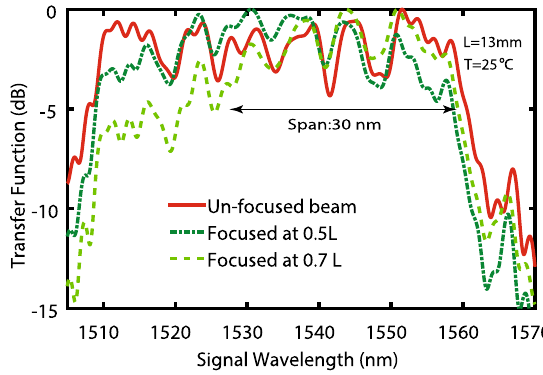
Figure 2. Normalized transfer functions of SC-PPLN using plane wave (solid line) and focused beams at two different positions of 0.5 L and 0.7 L along the grating. Focusing suppresses the side-lobes in the transfer function far from the phase-matching wavelength of the grating in the focusing point. The focal point is optimized to be at 0.7 L to achieve the maximum up-conversion power for 1550 nm, and to maintain the required 30 nm working bandwidth.